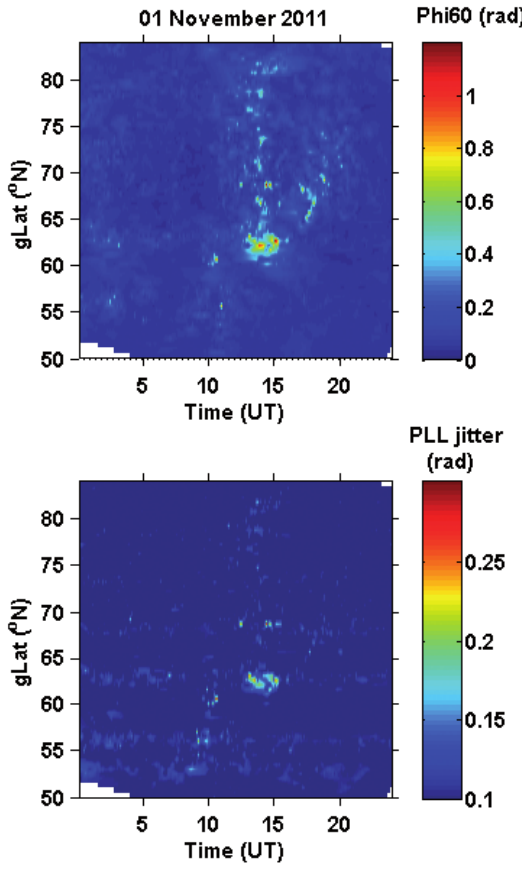
Figure 7. Phase scintillation index v U (a) and receiver PLL jitter maps (b) as functions of UT and IPP geographic latitude for the CHAIN GPS L1